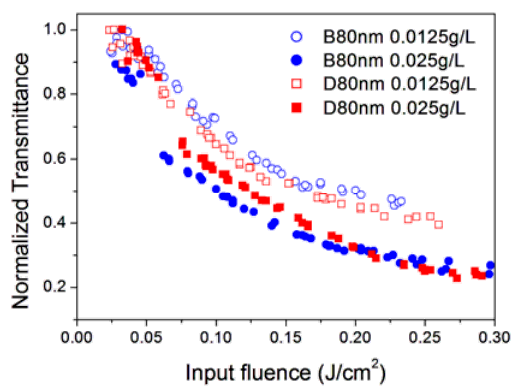
Figure 6. Optical limiting at 355 nm for B80nm and D80nm samples at two different nanoparticle concentrations.